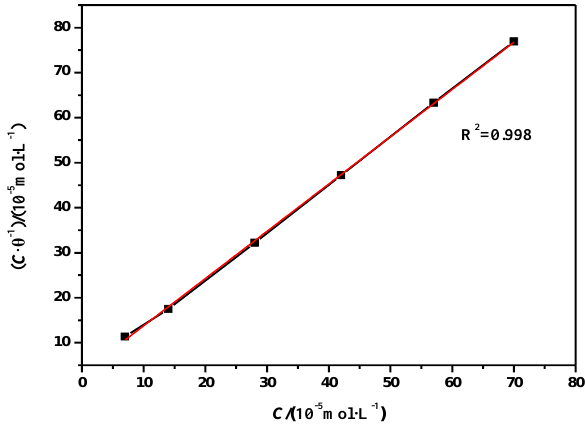
Figure 8. Langmuir isothermal adsorption curve of corrosion inhibitor MBT.